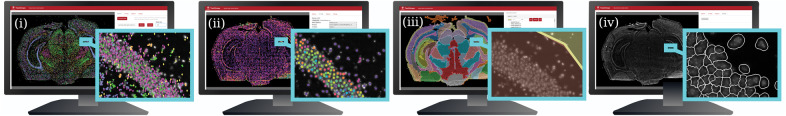
TissUUmaps can simultaneous display image data and point data, e.g. DAPI stained cell nuclei imaged using fluorescence microscopy combined with: (i) gene expression, (ii) cell morphology (measured by CellProfiler), (iii) manually or automatically drawn regions and (iv) cell outlines (segmented by CellProfiler). Multiple viewers can be instantiated and synchronized. TissUUmaps allows for operations in the image data through plugins, such as shaders, brightness and contrast modification